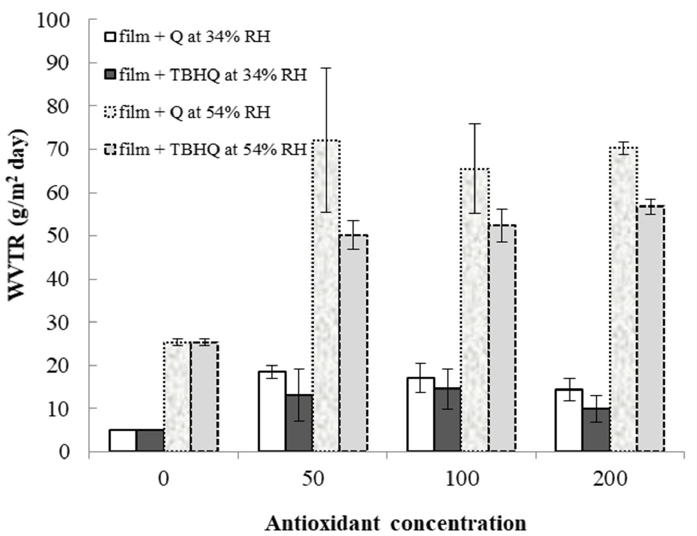
Figure 7. Water vapor transmission rates of cassava starch/gelatin films with quercetin (Q) and TBHQ (T) at 34 and 54% RH.